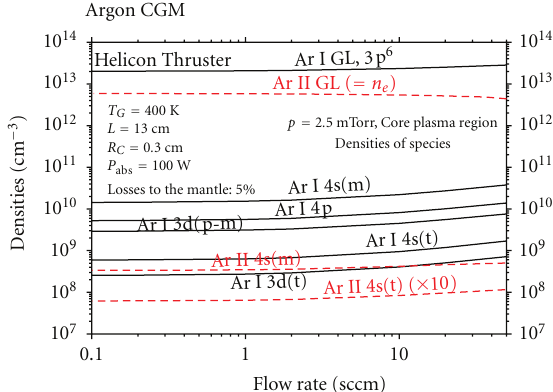
Figure 21: Variation of the densities of species as a function of the flow rate for a pressure of 2.5